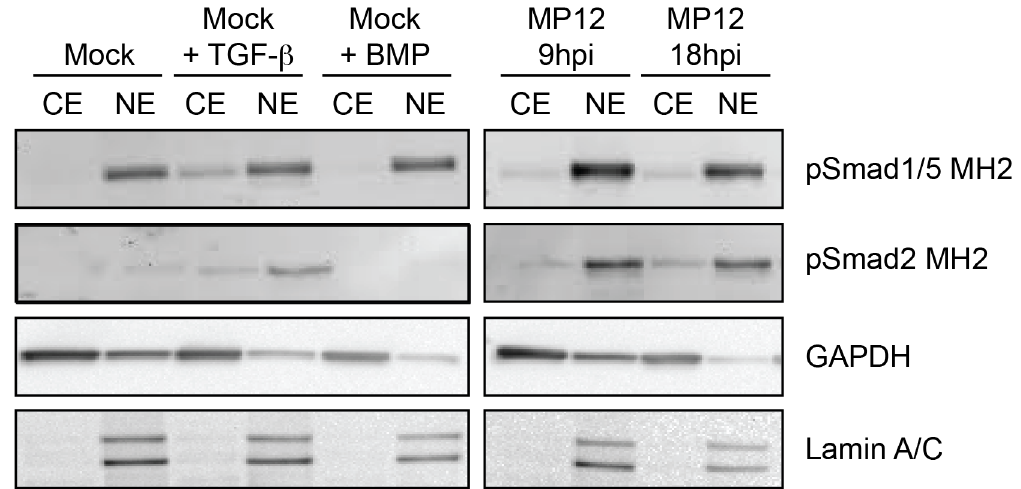
Fig 5. Nuclear localization of phosphorylated Smad proteins. HSAEC cells either alone (Mock), treated with TGF- β 3 (50ng/ mL, 2hrs), BMP-4 (50ng/mL, 2hrs), or infected with MP12 (MOI 5) for 9 or 18hpi were cell fractionated. 10ug of nuclear extracts (NE) or cytoplasmic extracts (CE) were probed for pSmad1/5 MH2, pSmad 2 MH2, GAPDH and Lamin A/C levels.